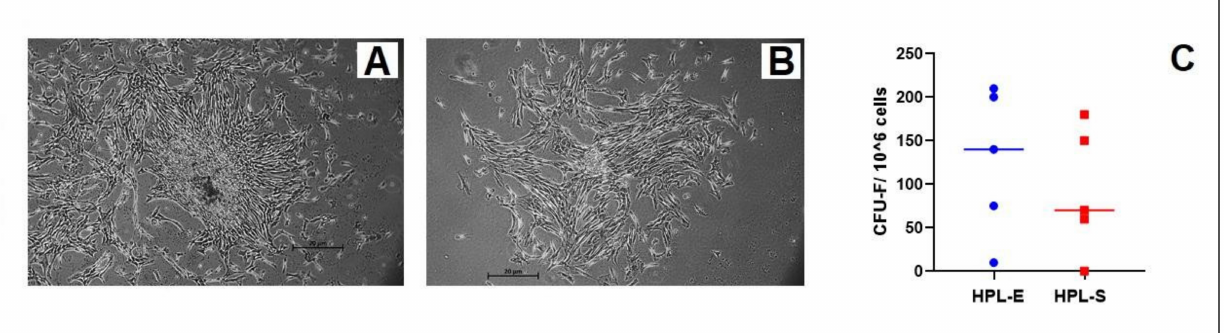
Figure 4. Representative phase images at 5 × magnification of CFU-Fs after 7 days from seeding. CFU morphology of BM-MSCs cultivated in HPL-E ( A ) and in HPL-S ( B ). In ( C ), blue and red dots report CFU-F/10 6 cells of BM-MSCs batches with HPL-E and HPL-S, respectively. No significant differences were observed.